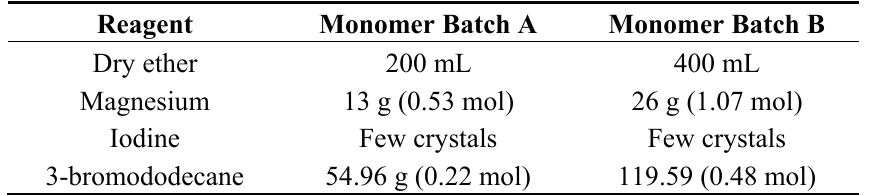
Table 1. Amounts of used reagents when the Grignard reagent for monomer batches A and B was